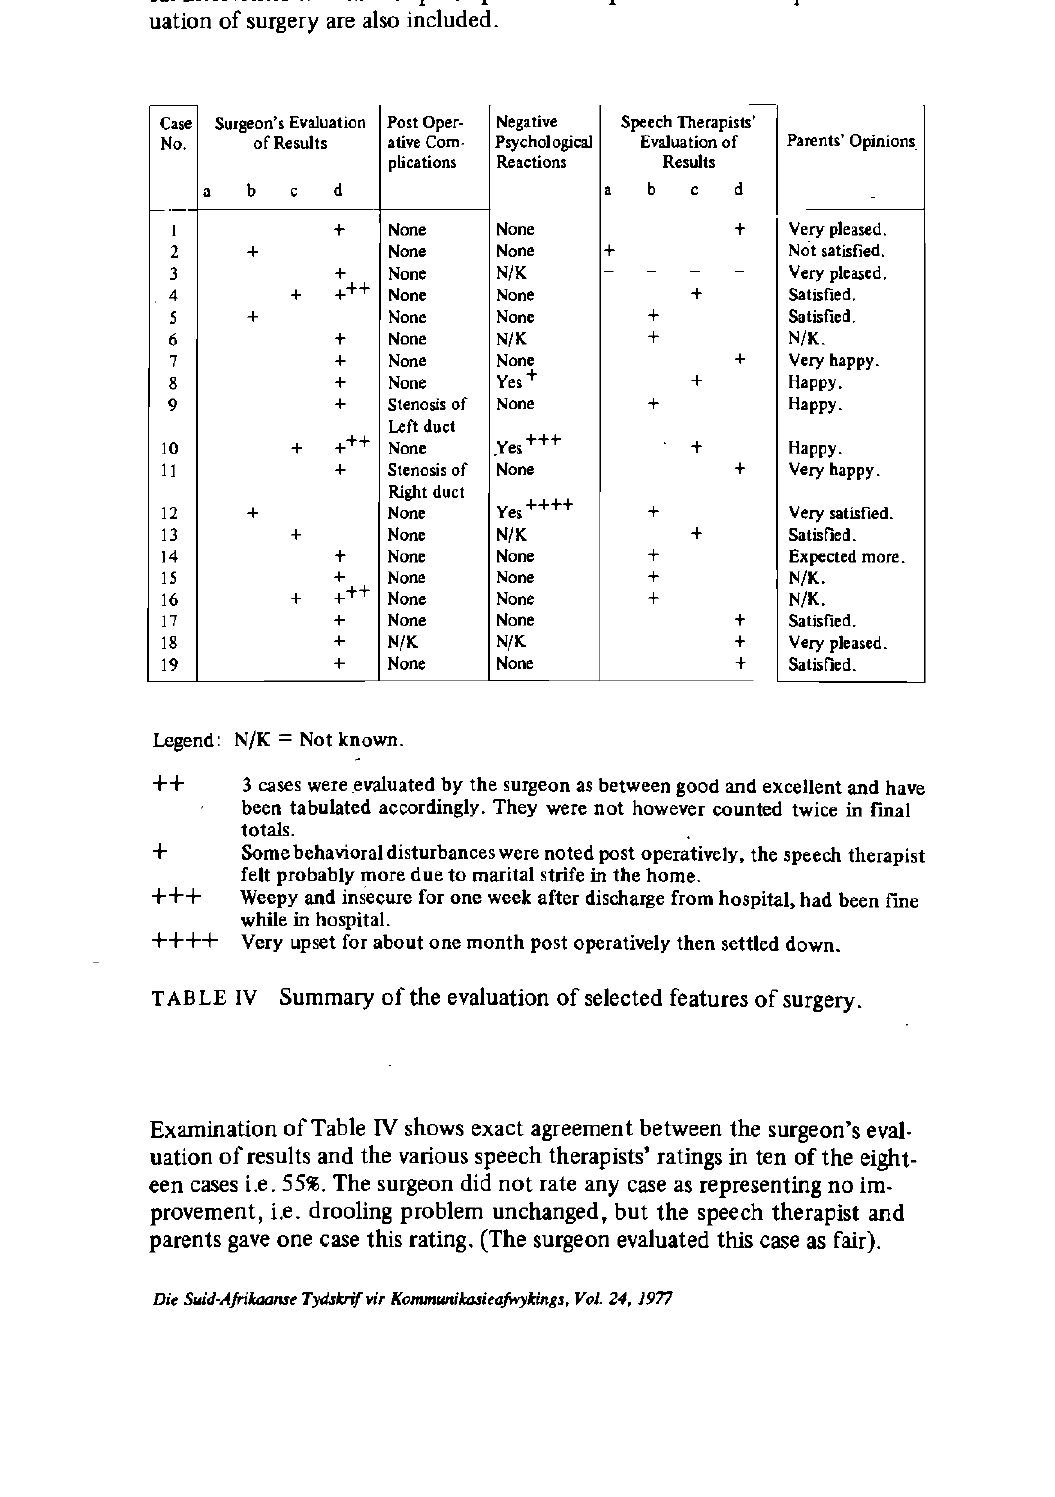
Table IV consists of a comparison between the surgeon's evaluation of results achieved and the various speech therapists' ratings of the success of the surgi- cal intervention. Details of post operative complications and the parents' eval- uation of surgery are also included.